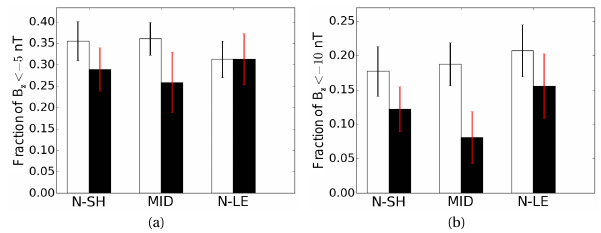
Figure 7. Dependence of PMS occurrence on southward magnetic field B z (in GSM coordinates) in the same format as Figure 5. The investigated parameter is the fraction of sub-region covered by (a) B z < − 5nT, (b) B z < − 10nT. The error bars show the extent of one standard